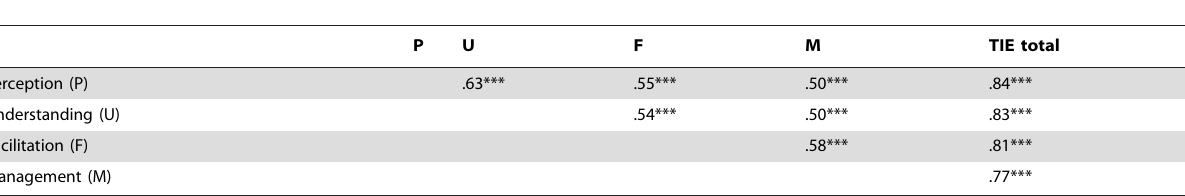
Table 4. Correlations between TIE subscales and the total